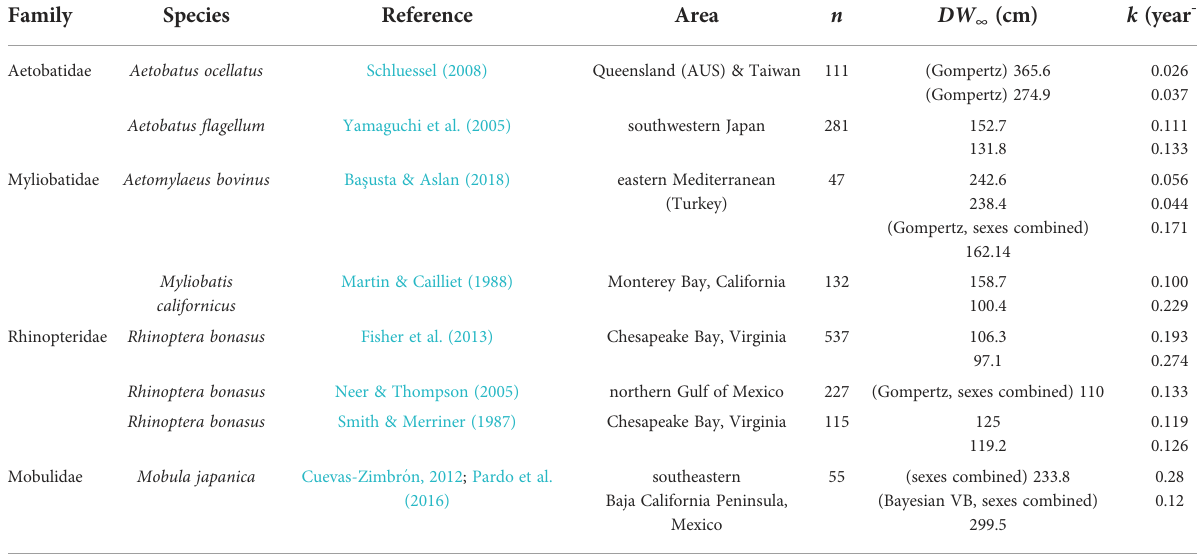
TABLE 7 Von Bertalanffy growth parameters estimated in Myliobatiformes using vertebral ageing.